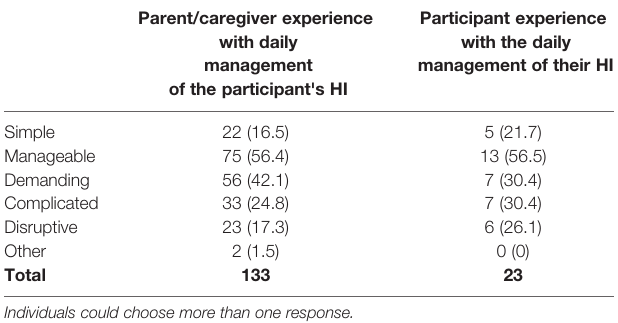
TABLE 15 | Parent/caregiver experience with worry because of the participants HI, by age groups. Do you worry because of the participant's